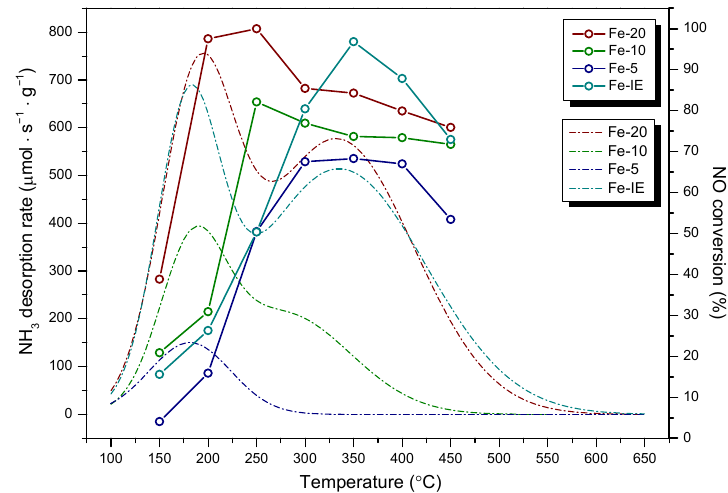
Figure 13. NH 3 -TPD profiles vs. NH 3 -SCR activity of the samples.